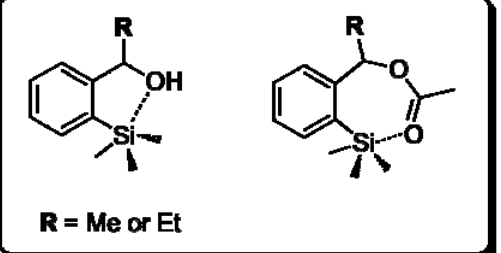
Figure 1. Possible pseudo-pentacoordinated species that can be present on the active site of the enzyme.